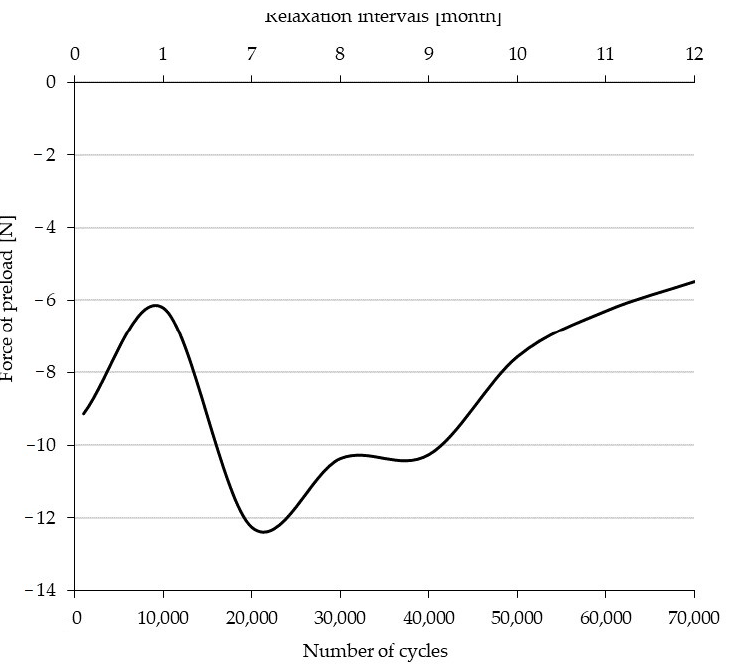
Figure 8. Preload force period of the ski after 0 mm deflection in the interval 0–70,000 cycles as a function of relaxation time.